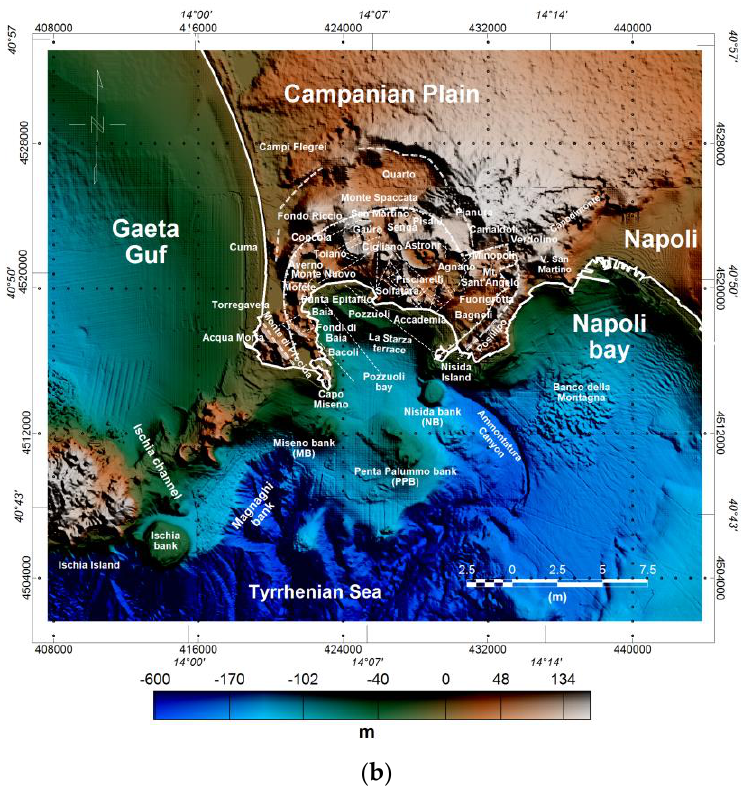
Figure 2. ( a ) Regional Digital Elevation Model of the Campanian Plain by EMODnet consortium [30]. ( b ) High resolution Digital Elevation Model of the Phlegraean Fields caldera by ISMAR − CNR [31]. CFc formed as a consequence of the Neapolitan Yellow Tuff (NYT) eruption (ca. 15